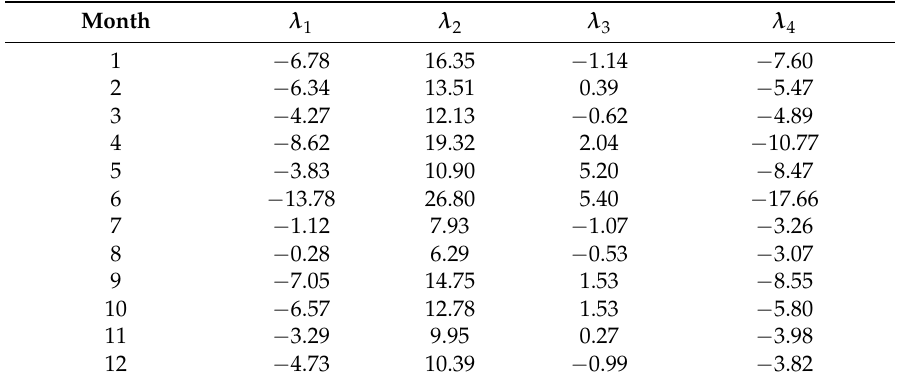
Table 1. Estimation of Lagrange multipliers for maximum entropy (ME)-based marginal distribution of monthly streamflow.